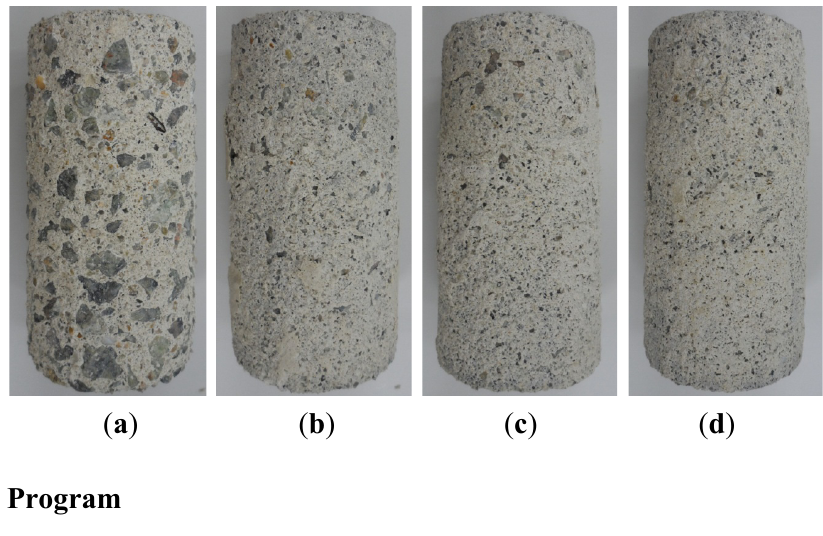
Figure 8. Surfaces of ( a ) R40-CON; ( b ) R40-NS5; ( c ) R40-NS7.5; and ( d ) R40-NS10 samples after 4 weeks of immersion in sulfuric acid.